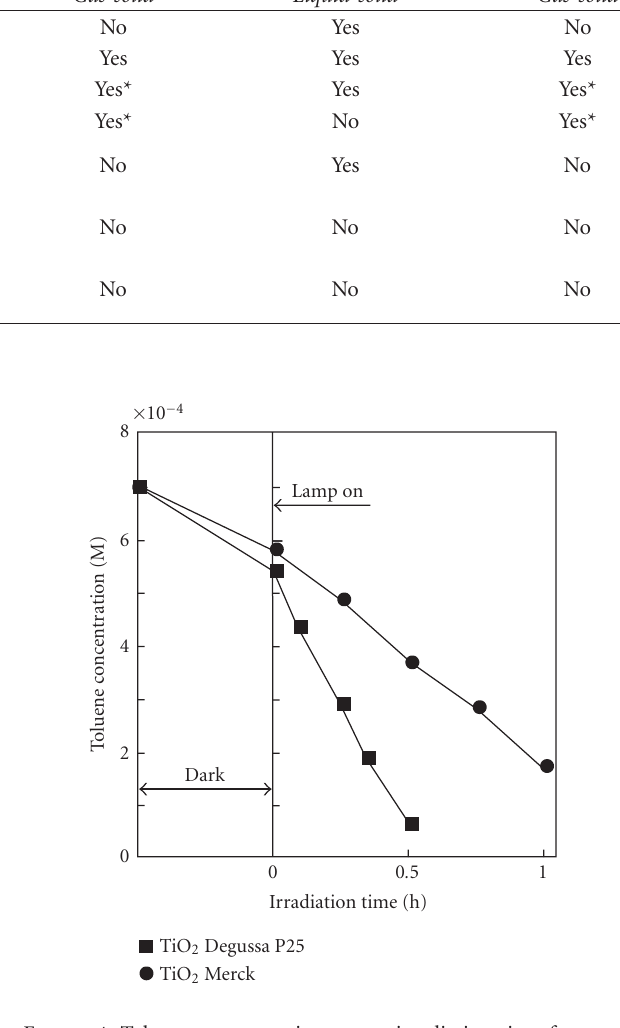
Figure 4: Toluene concentration versus irradiation time for runs carried out in batch photoreactor by using TiO 2 Degussa P25 ( (cid:2) ) and TiO 2 Merck (